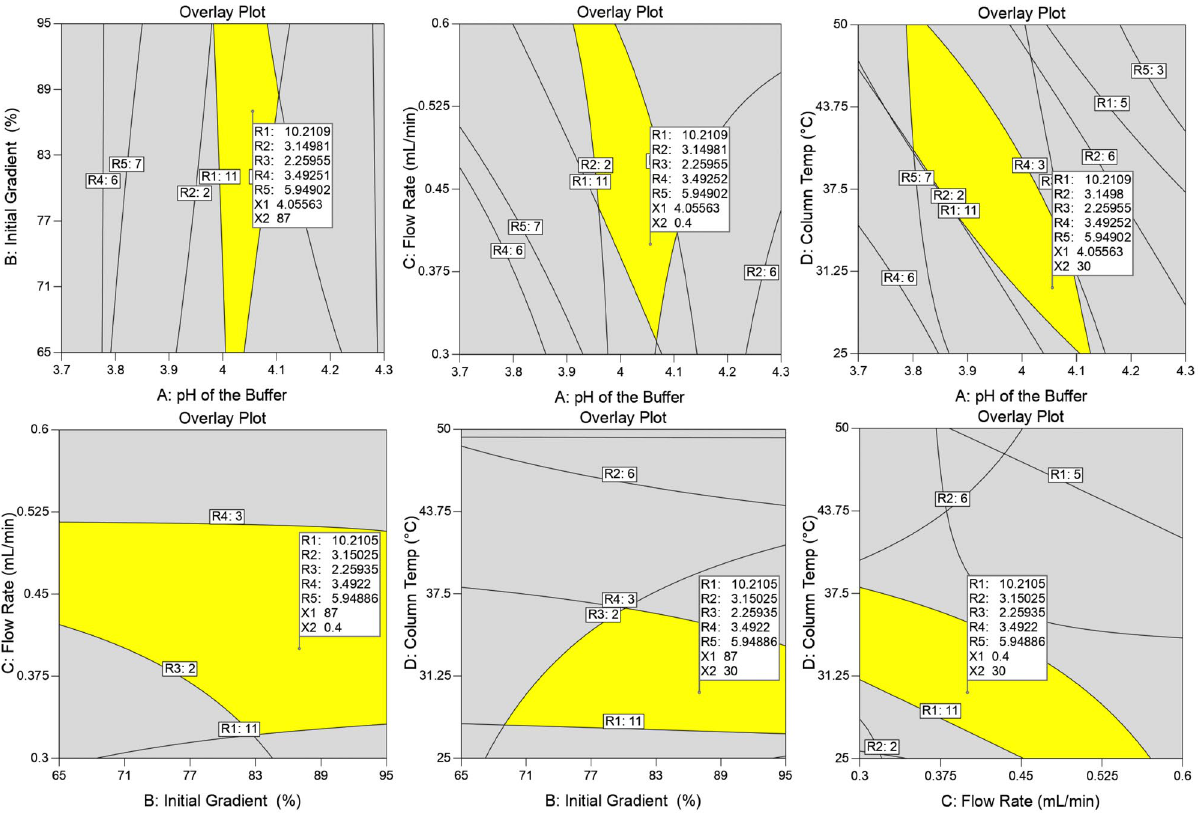
Figure 3. The overlay plots from the graphical